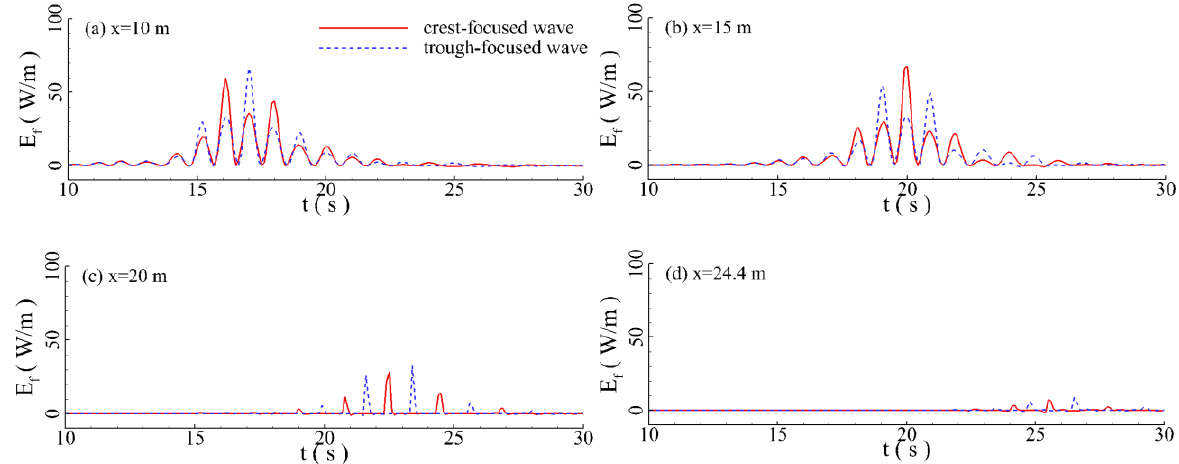
Figure 13. Comparisons of the energy flux at different locations.